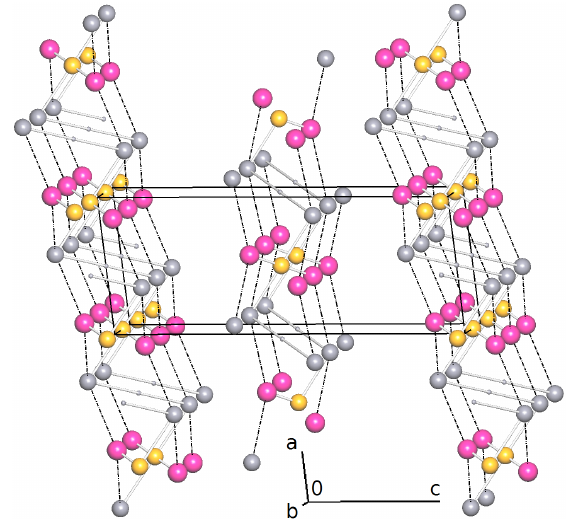
Figure 3. Simplified net calculated with ToposPro [32]. Large gray spheres represent the nodes of Sal 2 − , pink spheres H 2 O and yellow spheres Fe 3 + . The O-H hydrogen atoms on special positions are drawn as small gray spheres. Coordinative Fe-O bonds are drawn as sticks and hydrogen bonds are drawn as dashed